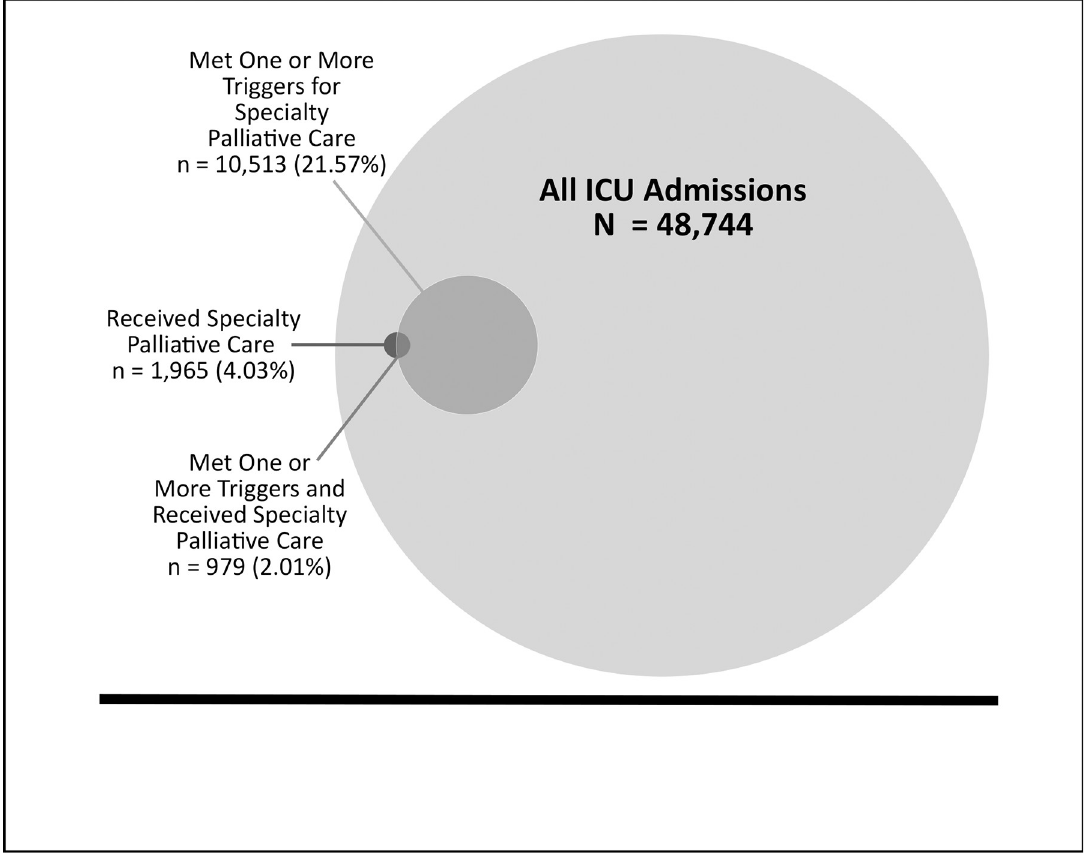
Fig 1. The relationship between actual specialty palliative care delivery and recommended trigger criteria among all adults admitted to the intensive care unit. Of 48,744 eligible intensive care unit admissions, 10,513 (21.57%) met one or more triggers for specialty palliative care consultations, and 1,965 (4.03%) received specialty palliative care consultation. Of all intensive care unit admissions, only 979 (2.01%) both received specialty palliative care and met one or more triggers for specialty palliative care.